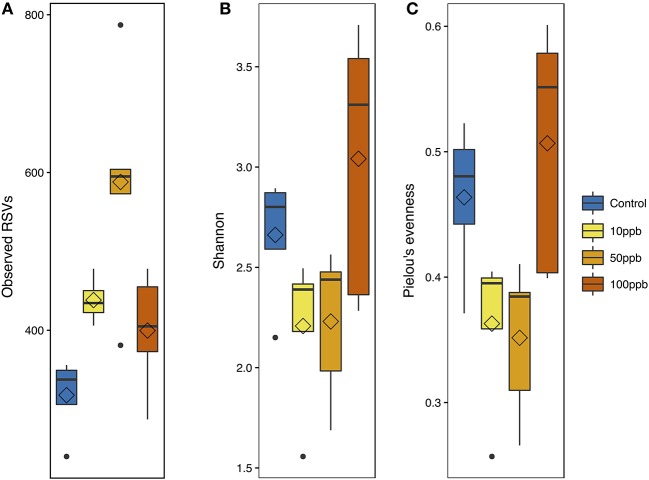
Alpha diversity metrics with arsenic exposure. (A) Observed ASV measurements [F(2, 15) = 9.83; adj-P < 0.01]. (B) Shannon diversity measurements [F(2, 15) = 4.32; adj-P = 0.03]. (C) Pielou's evenness measurements [F(2, 15) = 6.04; adj-P = 0.01]. All metrics are plotted against arsenic concentration gradient; with mean (diamond) and median (line), and hinges as first and third quartiles (25th and 75th percentiles).